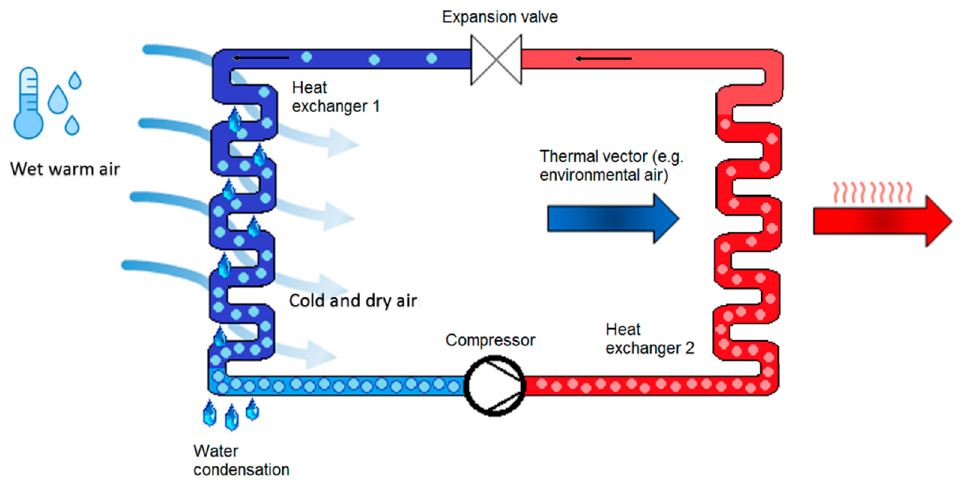
Figure 1. A representative reverse thermodynamic cycle.